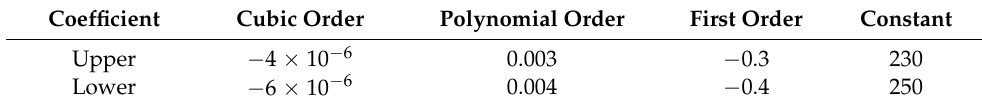
Table 8. Comparison of temperature distribution based on the two methods.